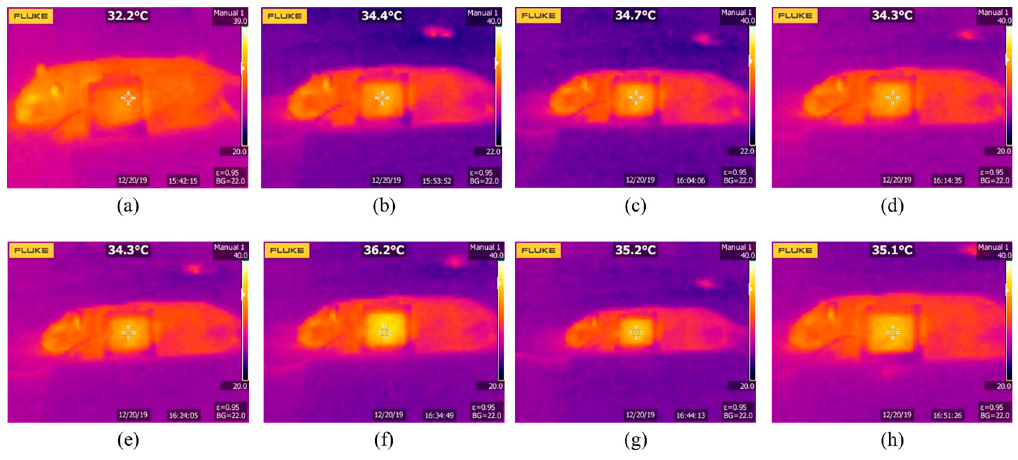
Figure 18. Temperature measured by thermal image sensor ( a ) Before charging, and ( b )~( h ) images captured every 10 min during charging.